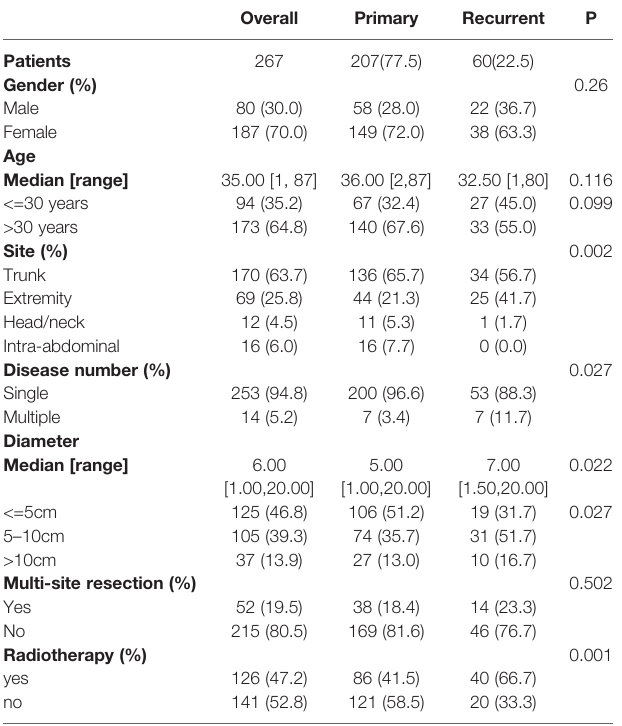
TABLE 1 | Patient demographics and tumor characteristics in the development